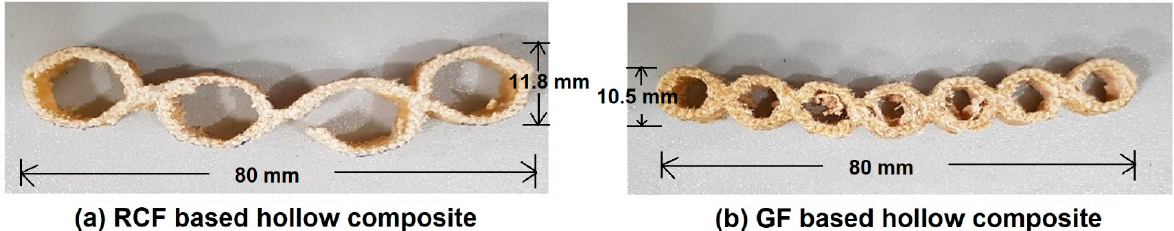
Figure 13. Ovalization after impact testing in ( a ) recycled cotton fiber-based hollow composites and ( b ) glass fiber-based hollow